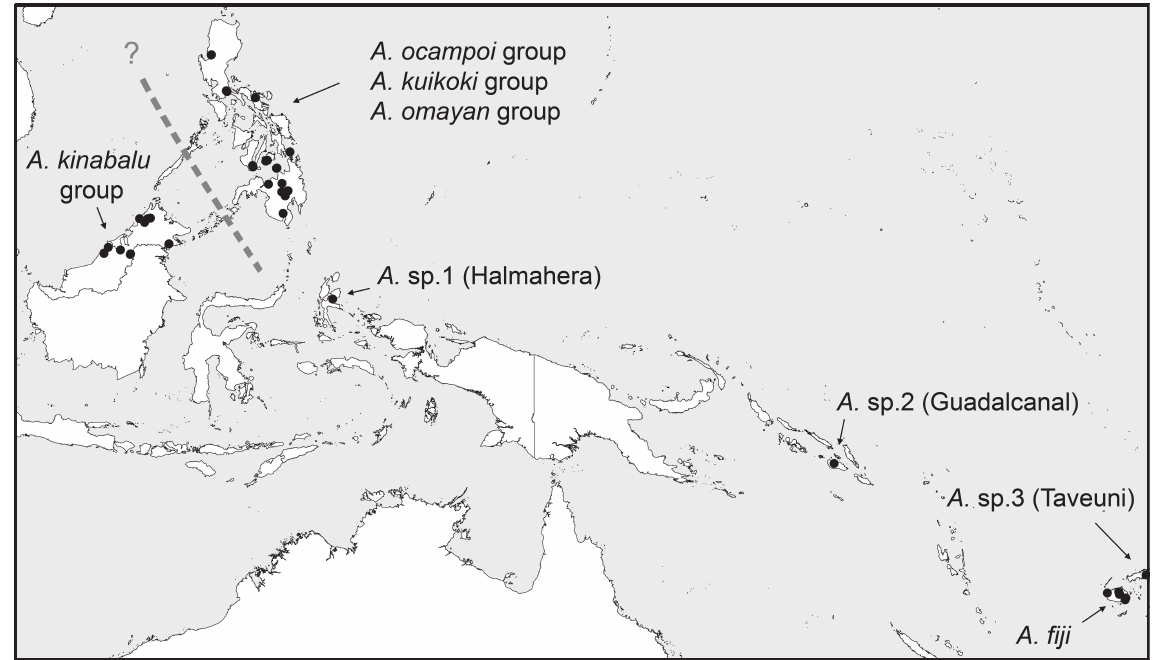
Fig. 2. Known distribution of Aetana . Shown are also three undescribed species that are known from poorly preserved specimens